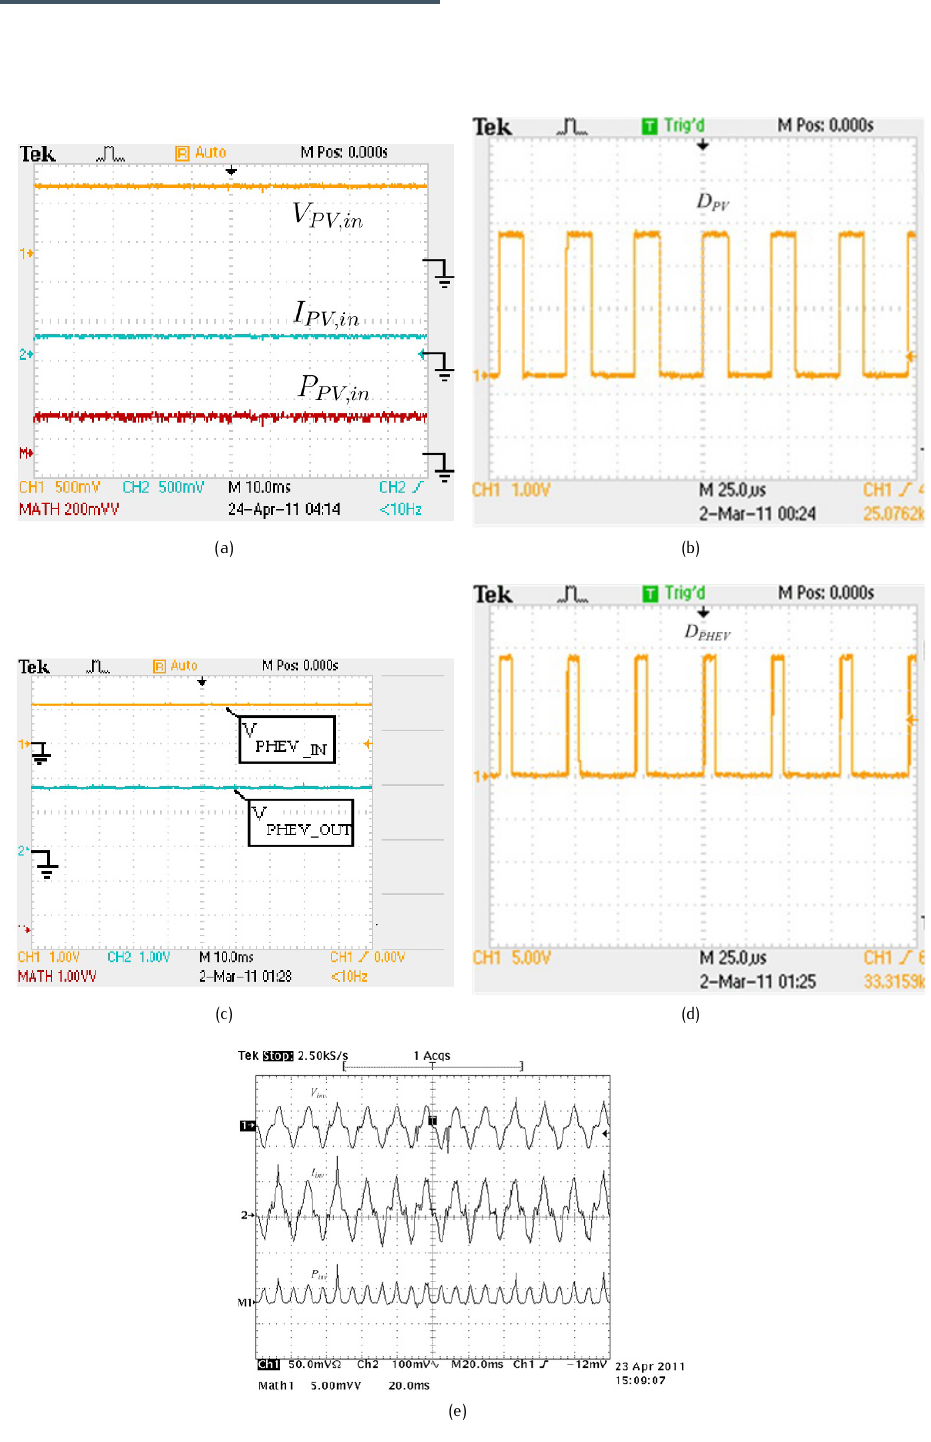
Figure 11. Output at different stages of proposed system for Case 2. (a) Output of PV stage boost converter for Case 2, (b) DPV for Case 2, (c) Output of PV stage boost converter for Case 2, (d) DPHEV for Case 2, (e) Output of inverter for Case 2